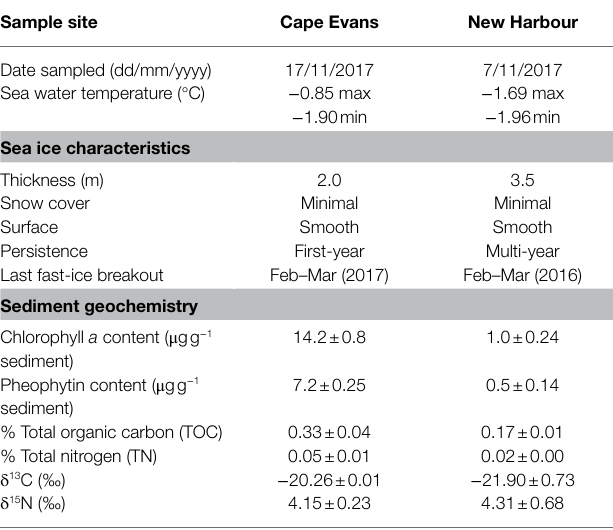
TABLE 1 | Sea ice and surface sediment characteristics at Cape Evans (17/11/2017) and New Harbour